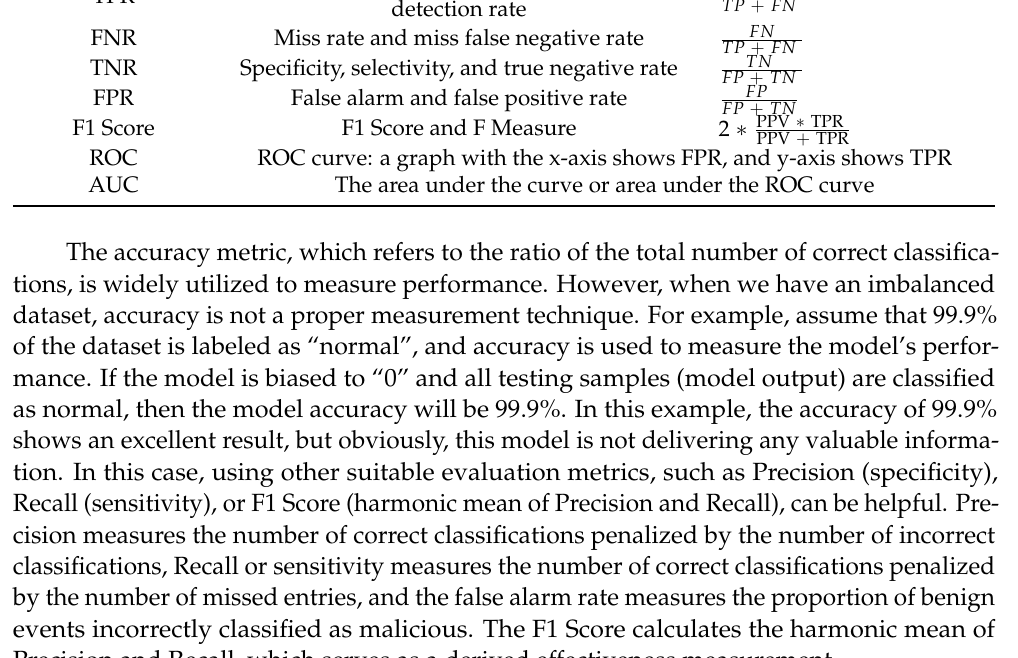
Table 4. The Equations and Explanations of Each Performance Measure.